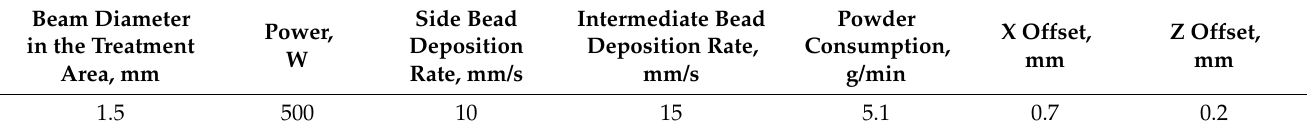
Table 1. Direct laser growth parameters [17].